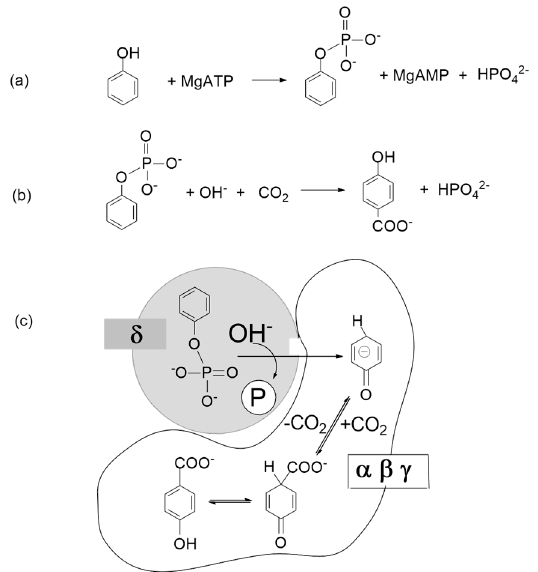
Figure 21. ( a , b ) Reactions catalyzed by phenylphosphate synthase and phenylphosphate carboxylase in Thauera aromatica ; ( c ) schematic represention of the α , β , γ , δ subunits of phenylphosphate carboxylase. Adapted with permission from [47]. Copyright 2009, Springer Nature.